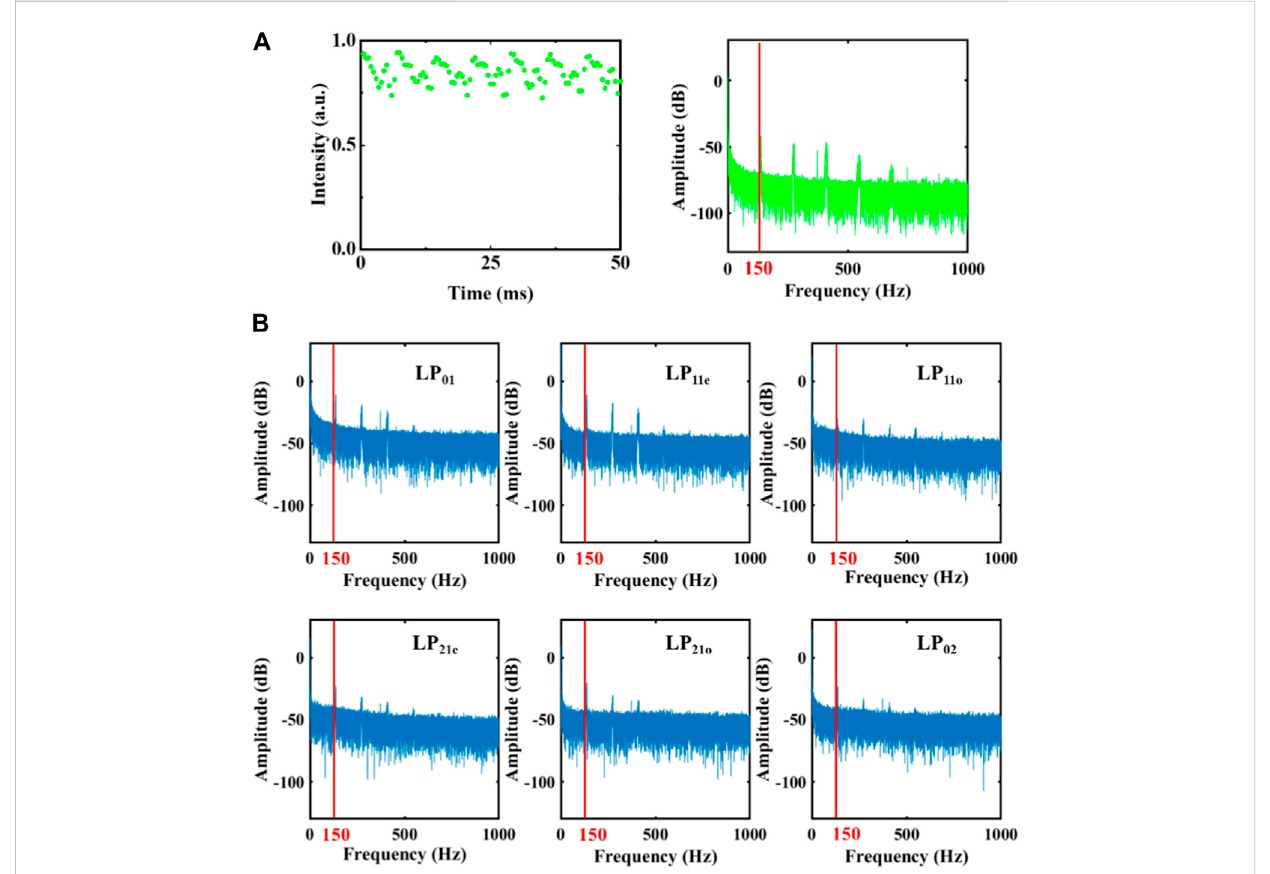
FIGURE 5 The variation of the power fl uctuation in the bucket of far- fi eld spot and modal coupling frequencies. (A) The power fl uctuation of the far- fi eld bucket in 50 ms and the related Fourier spectrum; (B) The characteristic frequencies of the individual modes (LP 01 , LP 11e , LP 11o , LP 21e , LP 21o , LP 02 ) in 30